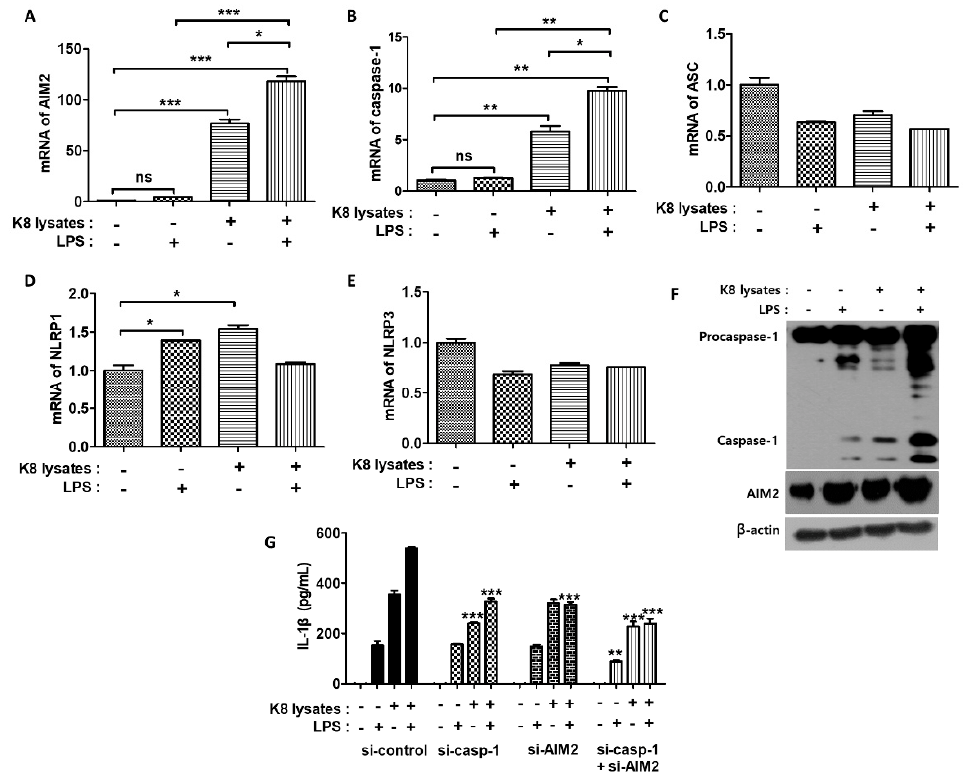
Figure 5. The regulation of inflammasomes by L. plantarum K8 lysates and LPS treatment. THP-1 cells were treated with 1 × 10 9 CFU/mL of L. plantarum K8 lysates for 18 h and/or 500 ng/mL of LPS for 4 h. mRNA levels of absent in melanoma 2 (AIM2) ( A ), caspase-1 ( B ), apoptosis-associated Speck-like protein containing a CARD (ASC) ( C ), NLR family pyrin domain containing (NLRP) 1 ( D ), and NLRP3 ( E ) were measured by real-time PCR. ( F ) Protein levels of AIM2, caspase-1, and β -actin were measured by western blot. ( G ) THP-1 cells were transiently transfected with control siRNA, AIM2 siRNA (GS9447), and caspase-1 siRNA (GS834) purchased from Qiagen. After 36 h transfection, cells were stimulated with L. plantarum K8 lysates and/or LPS. The IL-1 β level in the culture supernatants was determined using ELISA. Statistical analysis was conducted with one-way ANOVA followed by Tukey’s HSD post hoc test. * p < 0.05; ** p < 0.01; *** p <